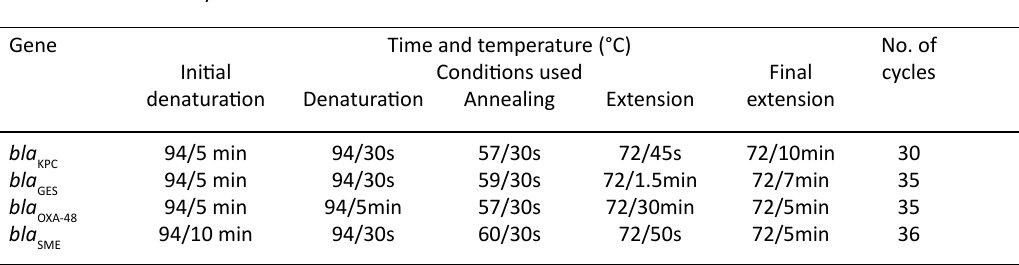
Table 2. The thermocycler reaction conditions